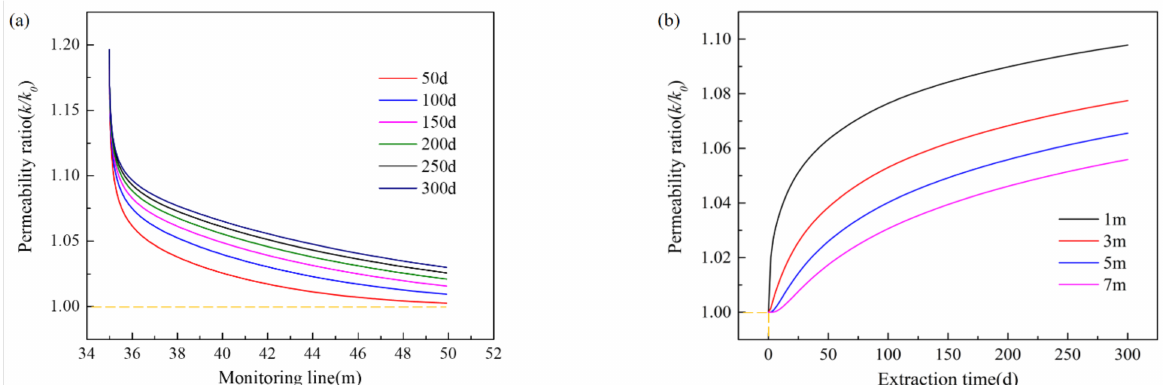
Figure 12. Permeability data monitored of monitoring line and monitoring points. ( a ) Permeability variation with monitoring line at different drainage times. ( b ) Permeability variation with time at different distances from the